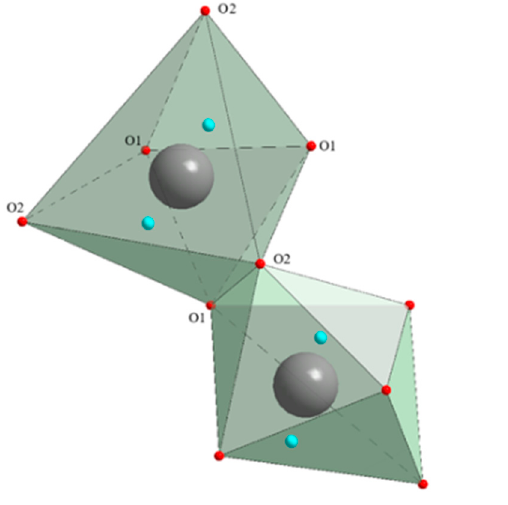
Figure 9. Bi L 3 -edge ( a ) XANES spectra and ( b ) EXAFS Fourier transforms ( k -range, 2–13 Å − 1 ) for the BGO:1.0Dy and BGO:0.1Dy samples.